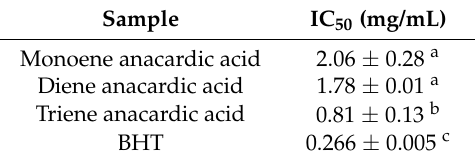
Table 2. Antioxidant activity of anacardic acids from Brazilian cashew nut shell liquid (CNSL).